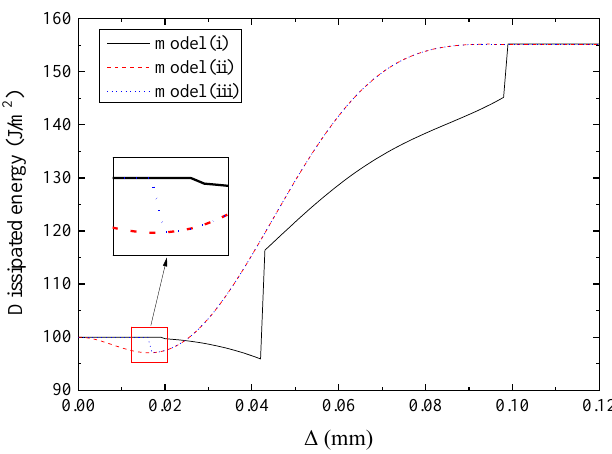
Figure 13. Dissipated energy in the process of proportional loading/unloading and mode I reloading, with the increase in the amplitude of proportional loading. Model (i) (solid line), model (ii) (dashed line), and model (iii) (dotted line).